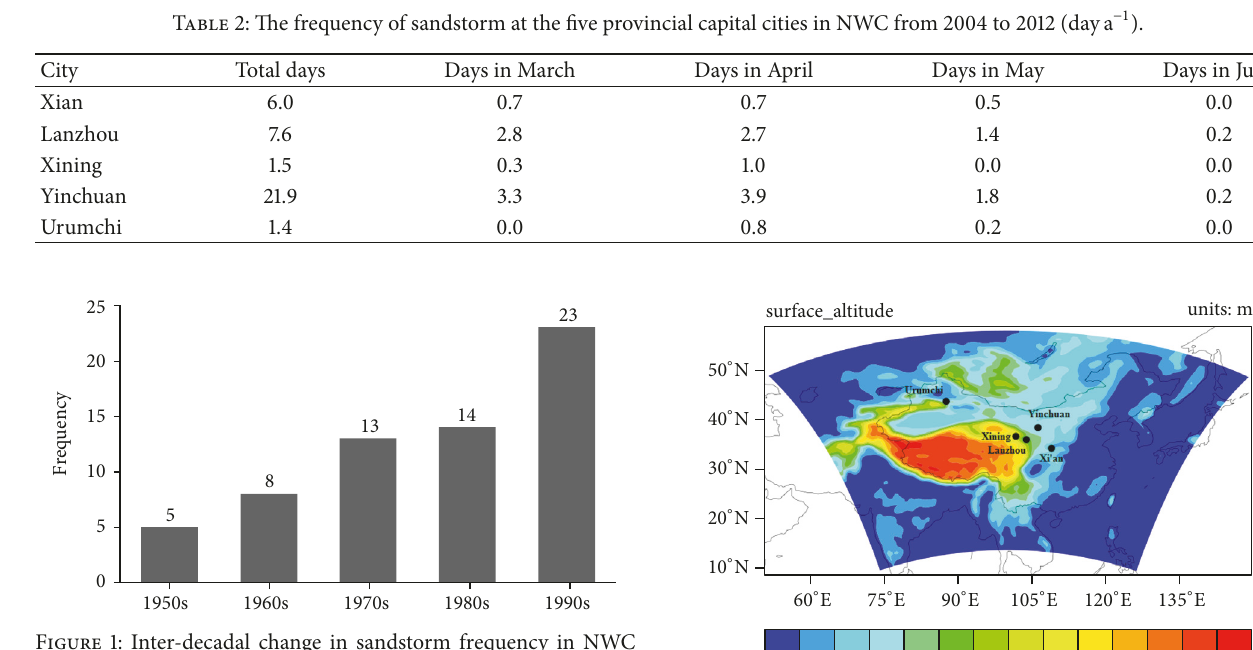
Figure 1: Inter-decadal change in sandstorm frequency in NWC between 1950 and 2000.